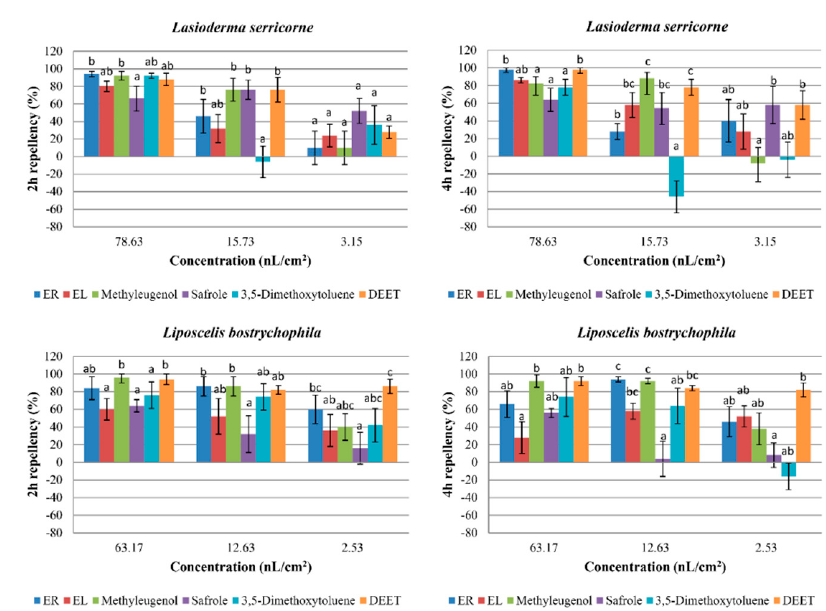
Figure 1. Percentage repellency (PR) of Asarum heterotropoides essential oil (EO) against Lasioderma serricorne and Liposcelis bostrychophila at 2 h and 4 h post-exposure. Means in the same column followed by the same letters do not differ significantly ( p > 0.05) in ANOVA and Tukey’s tests. PR was subjected to an arcsine square-root transformation before ANOVA and Tukey’s tests. *ER and EL: the essential oils from roots and leaves o f A. heterotropoides, respectively.